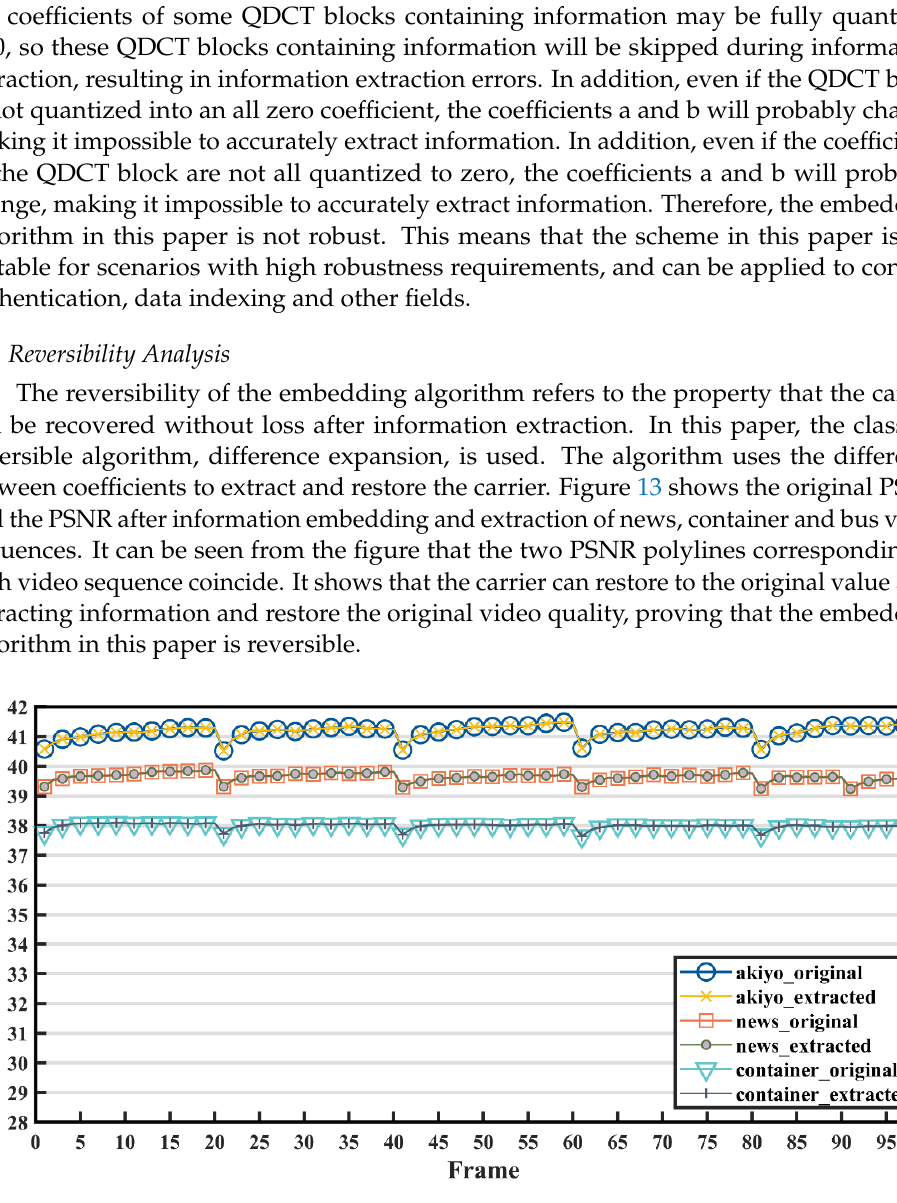
Figure 13. The original PSNR and the PSNR after information embedding and extraction.